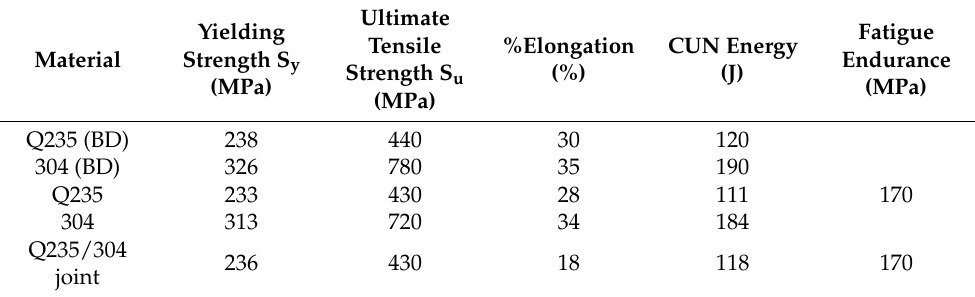
Table 2. Mechanical properties of Q235, SUS304 and bonded joints.